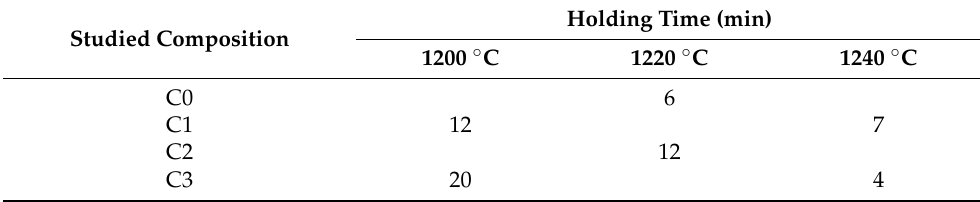
Table 5. Holding times at different firing temperatures of the studied